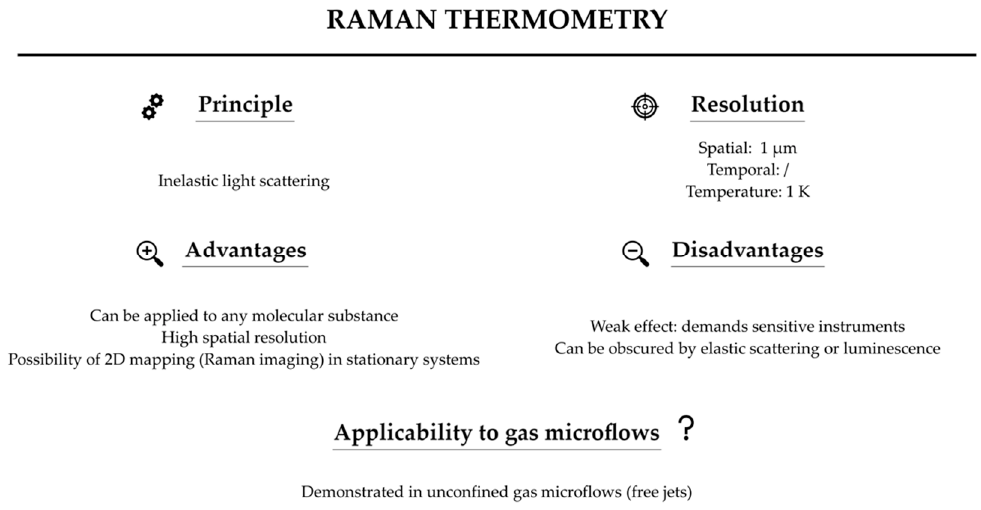
Figure 28. Summary of Raman thermometry features.